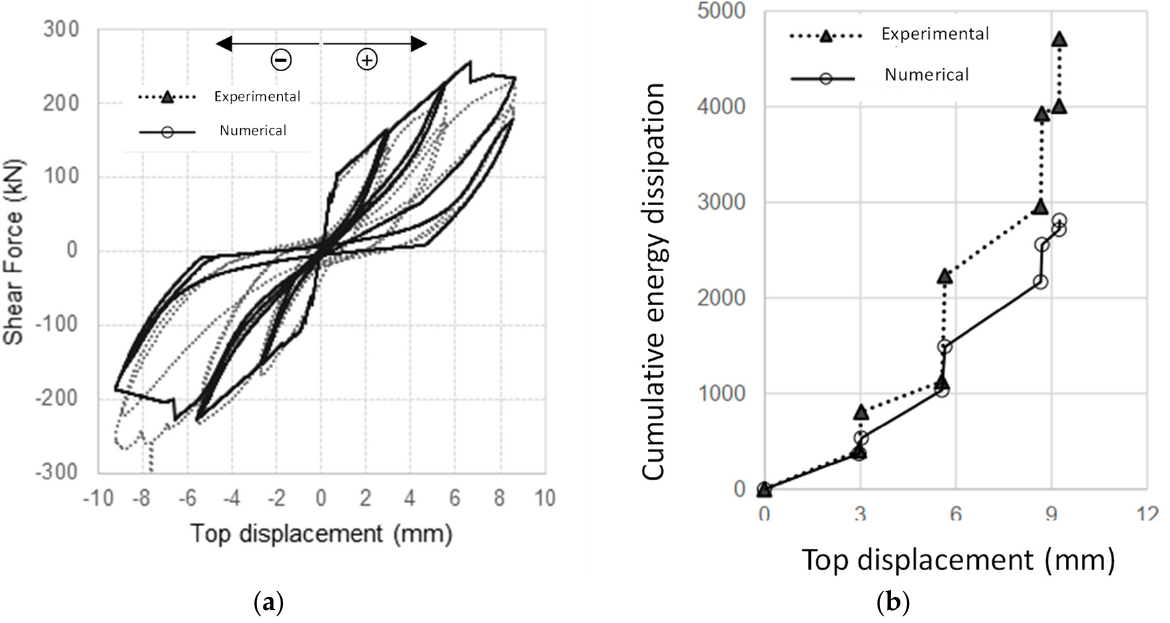
Figure 4. Numerical simulation of the specimen Inf_12 (wall w/o opening): ( a ) force–displacement curves; and ( b ) cumulative energy dissipation.